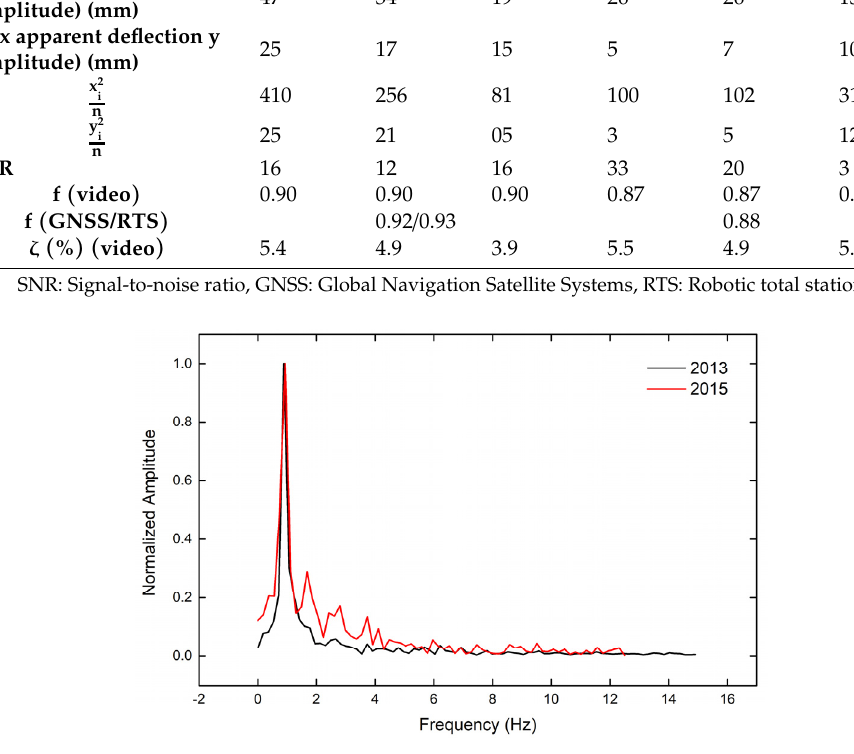
Figure 5. A comparative plot of the spectra of the free attenuation intervals of the oscillation of point P2 for the two years. The spectra are normalized to their maximum amplitude and reflect the first lateral modal frequency of the bridge (only the free attenuation intervals were analyzed).